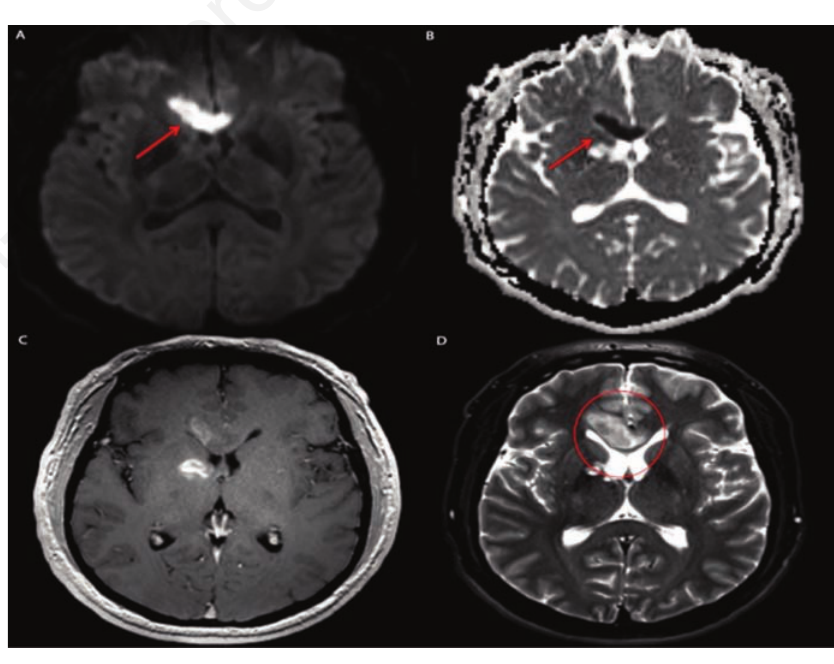
Figure 1. Case #1. A) and B) diffusion weighted sequence and apparent diffusion coeffi- cient map, respectively, demonstrate a focal area of restriction of diffusion involving the right rostrum, genu and body of the Corpus Callosum with mild enhancement on post- gadolinium T1W sequence (C) and moderate edema and local mass effect on T2W sequence (D). A second lesion involving the right basal ganglia and genu of the right internal capsule demonstrates incomplete peripheral enhancement with central necrosis, without mass effect or restriction of